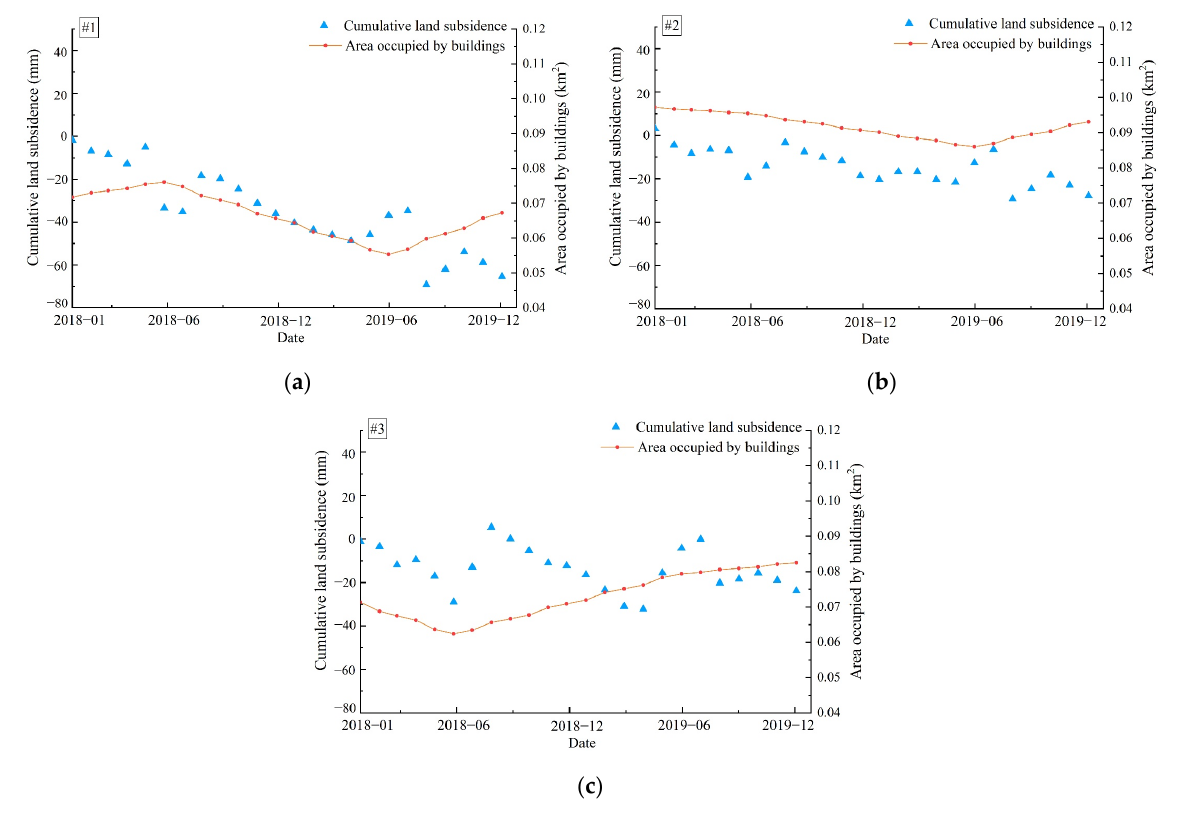
Figure 11. Cumulative land subsidence and area occupied by buildings in the 200 m buffer zone around each well: ( a ) well #1, ( b ) well #2 and ( c ) well #3.